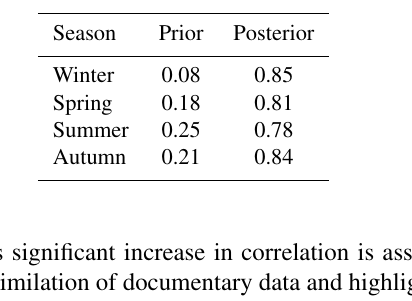
Table 4. Pearson correlation between the ModE-Sim ensemble and the CESM-LME multi-member mean temperatures over the Bur- gundian Low Countries for the 1420–1499CE period. 2m air tem- perature correlations have been calculated for each season before (prior) and after (posterior) assimilation of historical documents over the